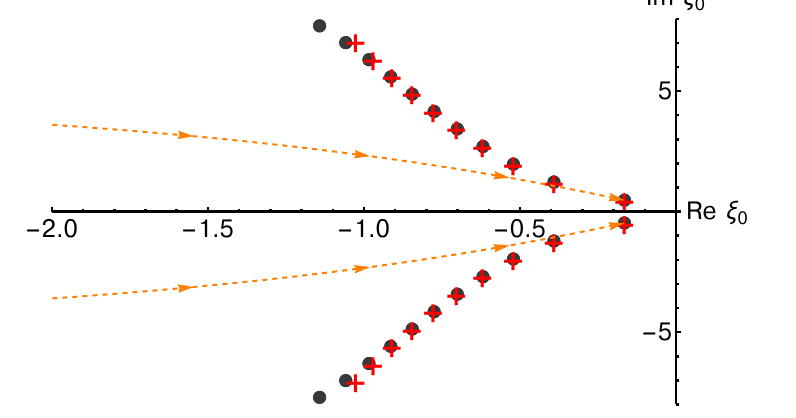
20) (right panel). We used n max = 300 terms −